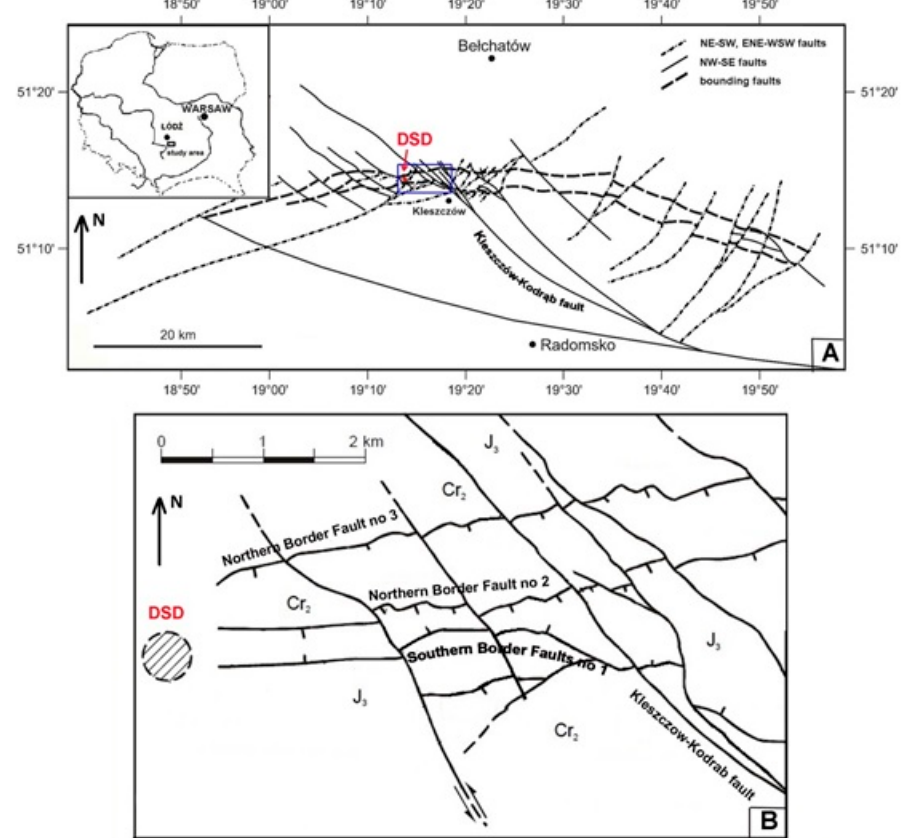
Figure 1. The localization of the study area (based on [25–27]): A —the structure of the Kleszczów graben, B —the structure of the Be ł chatów field near the D ę bina salt dome (DSD).